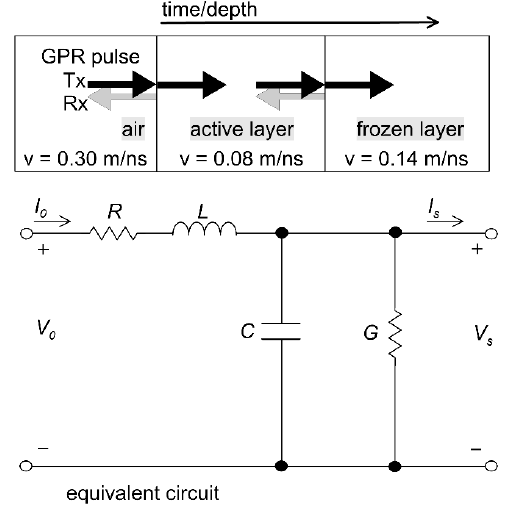
Figure 2. Diagrammatic model and equivalent electrical circuit for GPR pulse in a partially frozen setting.